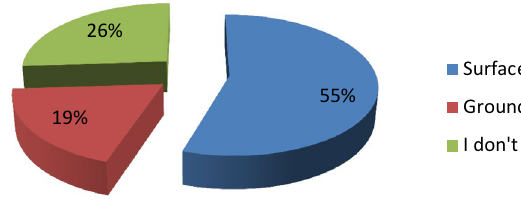
Fig. 6 Source of water supply of Bechar city